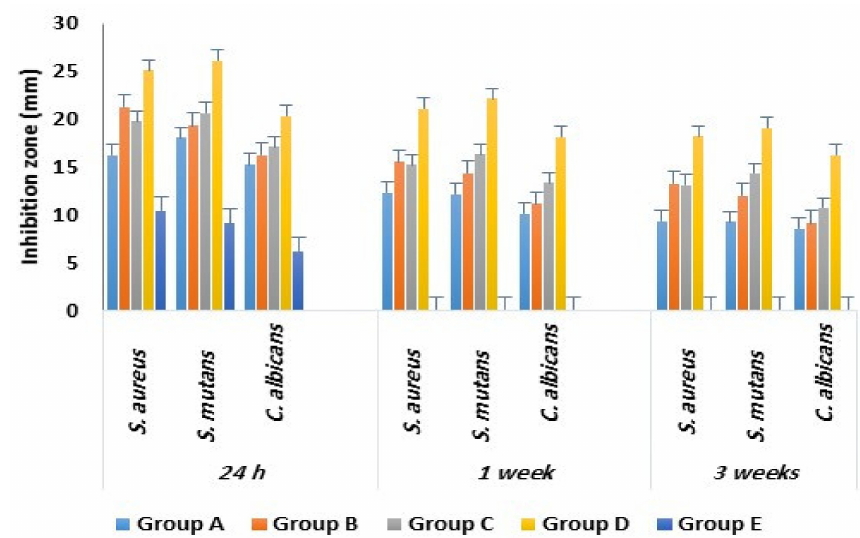
Figure 5. Antimicrobial efficacy of tested GIC specimens at different time intervals. GIC—Glass ionomer cement, Group A—GIC + lyophilized miswak, Group B—GIC + ZOE-AgNPS, Group